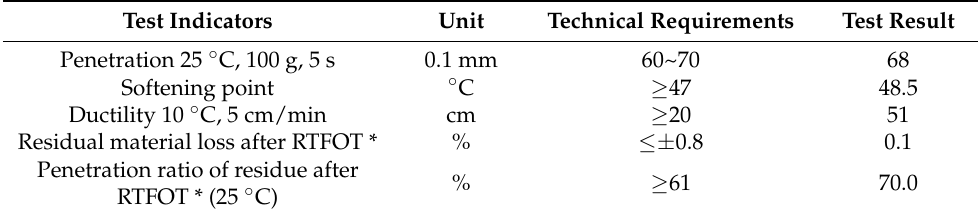
Table 1. Main technical indexes of matrix asphalt no.